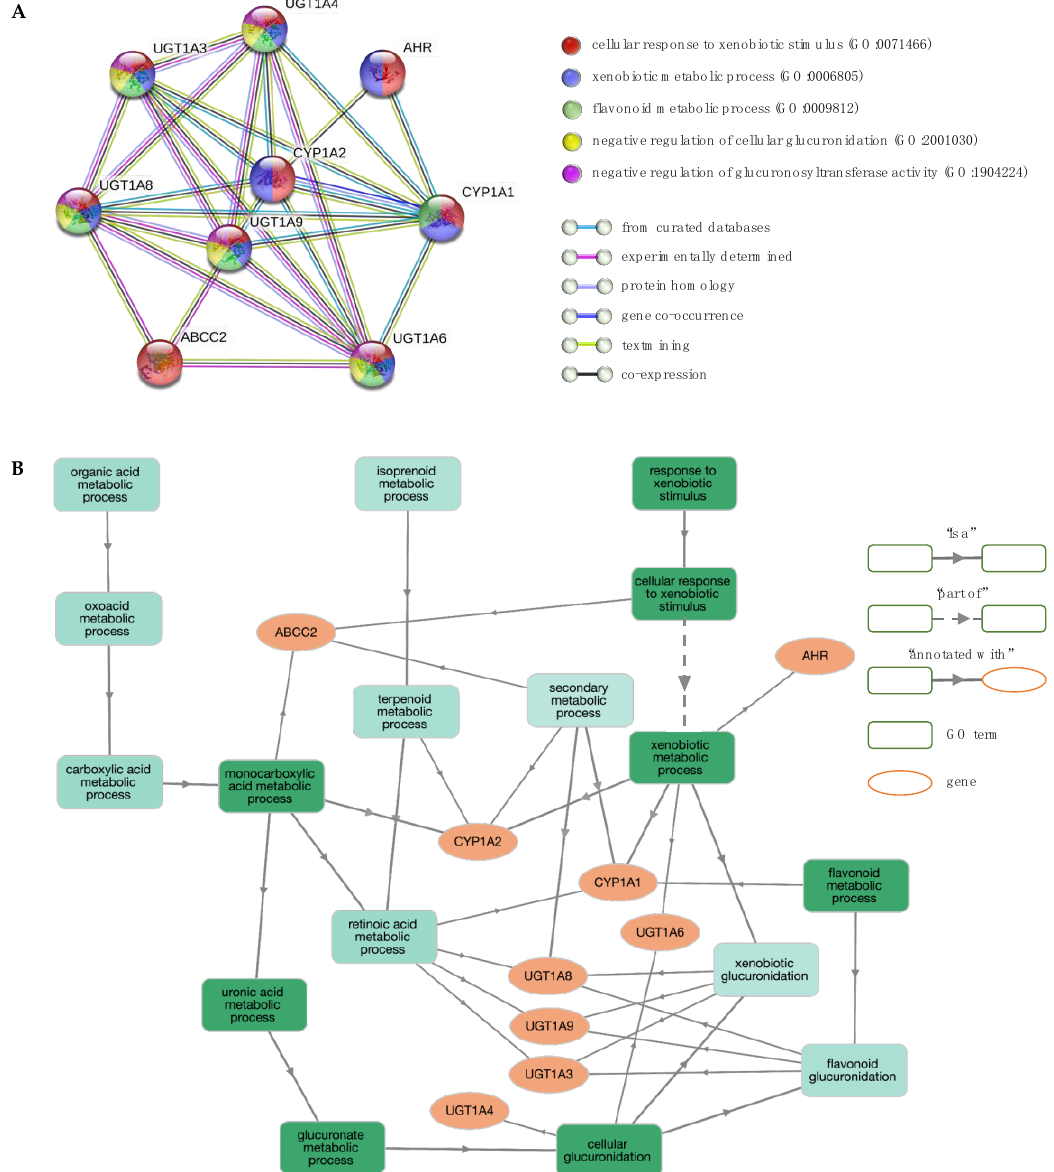
Figure 7. Network and enrichment analysis for response to iron chelators. ( A ) The PPI network contains nine nodes (proteins; circles) connected by edges (protein–protein interactions). The most significant GO BP terms are shown. ( B ) GO BP enrichment analysis using GOnet ( q value ≤ 0.01; p value ≤ 5.3 × 10 –9 ). Green colour intensifies as the significance level of enrichment decreases.